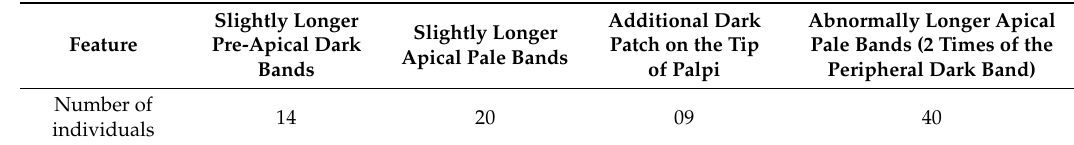
Table 3. Additional palp variations of adults.